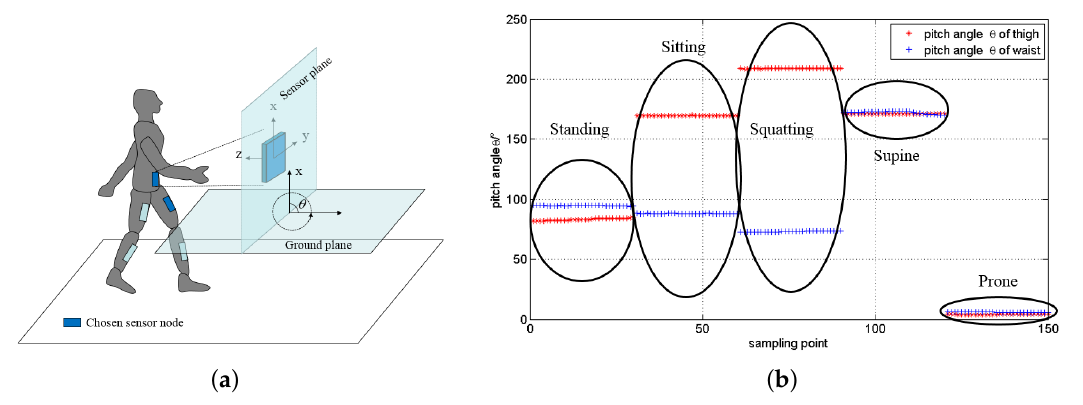
Figure 7. The features selection of posture recognition. ( a ) The illustration of pitch angle; ( b ) The pitch angles of the left thigh and waist in each